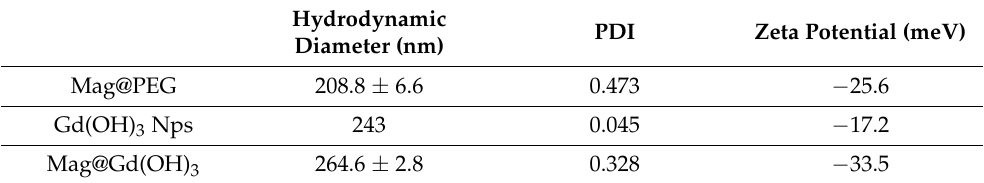
Table 1. Hydrodynamic diameter and zeta potential of Mag@PEG, Gd(OH) 3 Nps and Mag@Gd(OH) 3 .